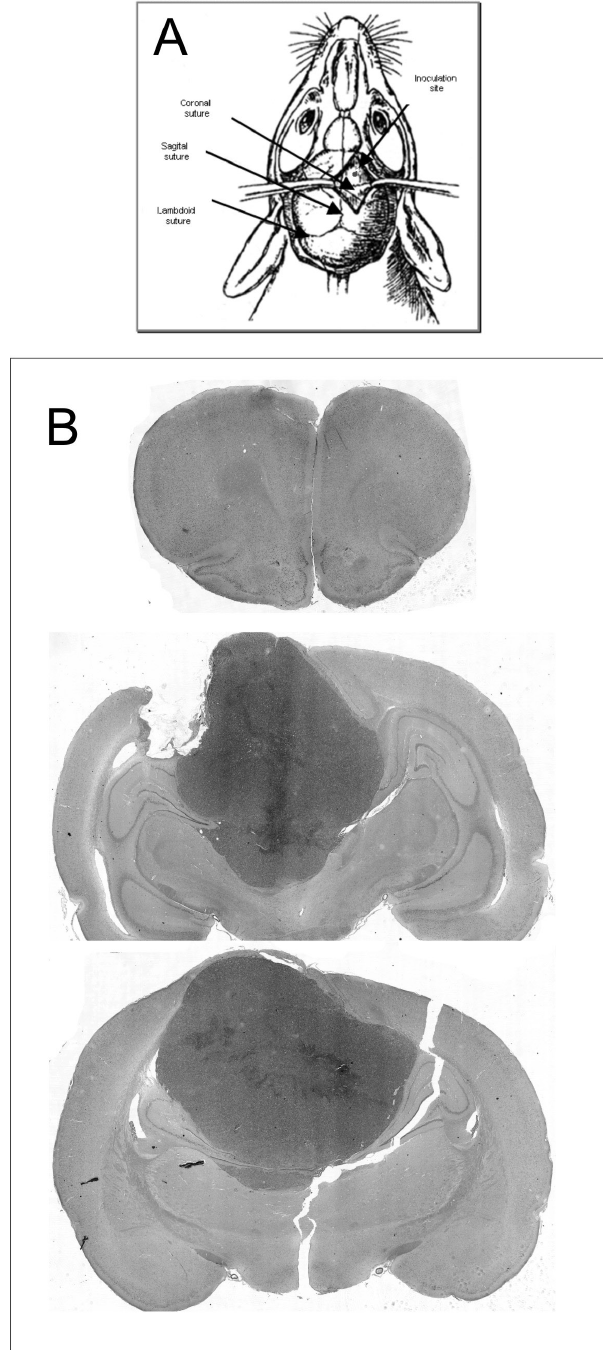
Figure 1 - A: Schematic of a rat skull showing the inoculation site with respect to the sutures (modified from Lal S et al. 18 ). B: Scanned slide of a coronal section shows a single tumor mass centered at the inoculation